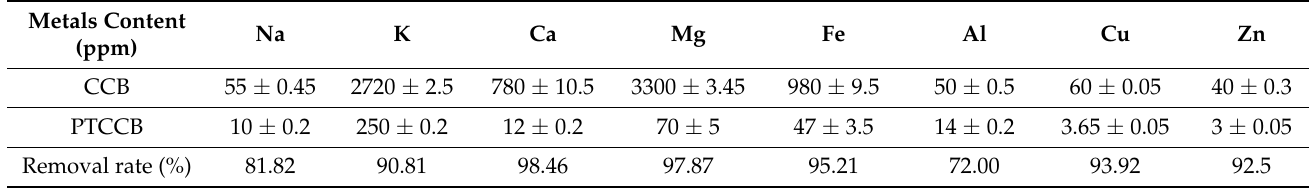
Table 3. The metals content in corn cob biomass (CCB) and pretreated corn cob biomass